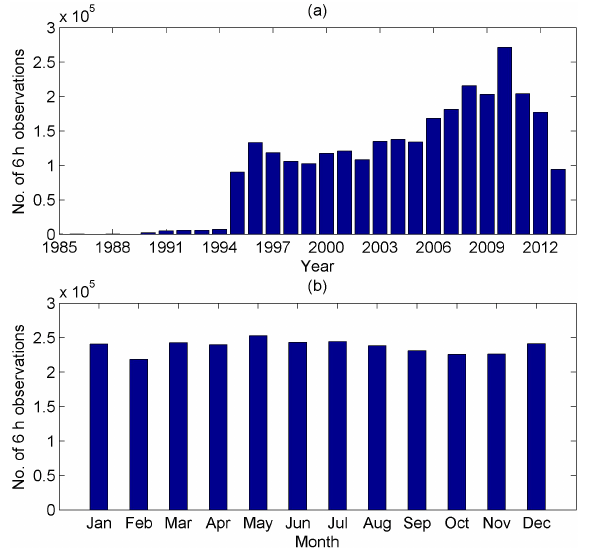
Figure 5. (a) Number of all drifter observations in each year since 1985, each observation is one 6h position from a drifter trajectory. (b) Number of all drifter observations at 6h intervals in each clima- tological calendar month.